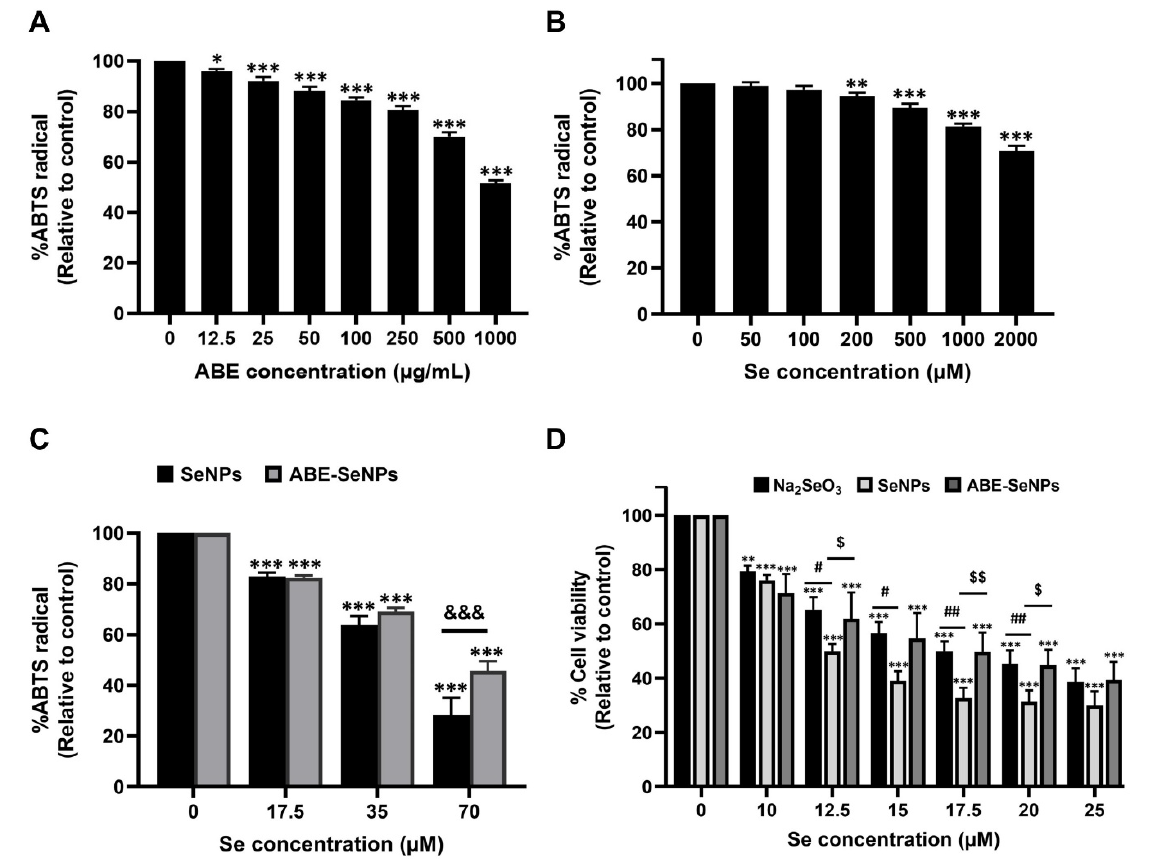
Figure 2. Antioxidant activity and cytotoxicity of ABE, selenium and Se nanoforms. ABTS+ scaveng- ing activity of ABE ( A ), selenium ( B ), and Se nanoforms (SeNPs and ABE-SeNPs) ( C ). Cell viability of RAW 264.7 macrophages treated with Na 2 SeO 3 , SeNPs, and ABE-SeNPs for 48 hours ( D ). (The data are indicated as mean ± SD of three independent experiments: * p < 0.05, ** p < 0.01, *** p < 0.001 compared to control (non-treated group), &&& p < 0.001 SeNPs compared to ABE-SeNPs, # p < 0.05, ## p < 0.01 compared to Na 2 SeO 3 , $ p < 0.05, $$ p < 0.01 SeNPs compared to ABE-SeNPs.).